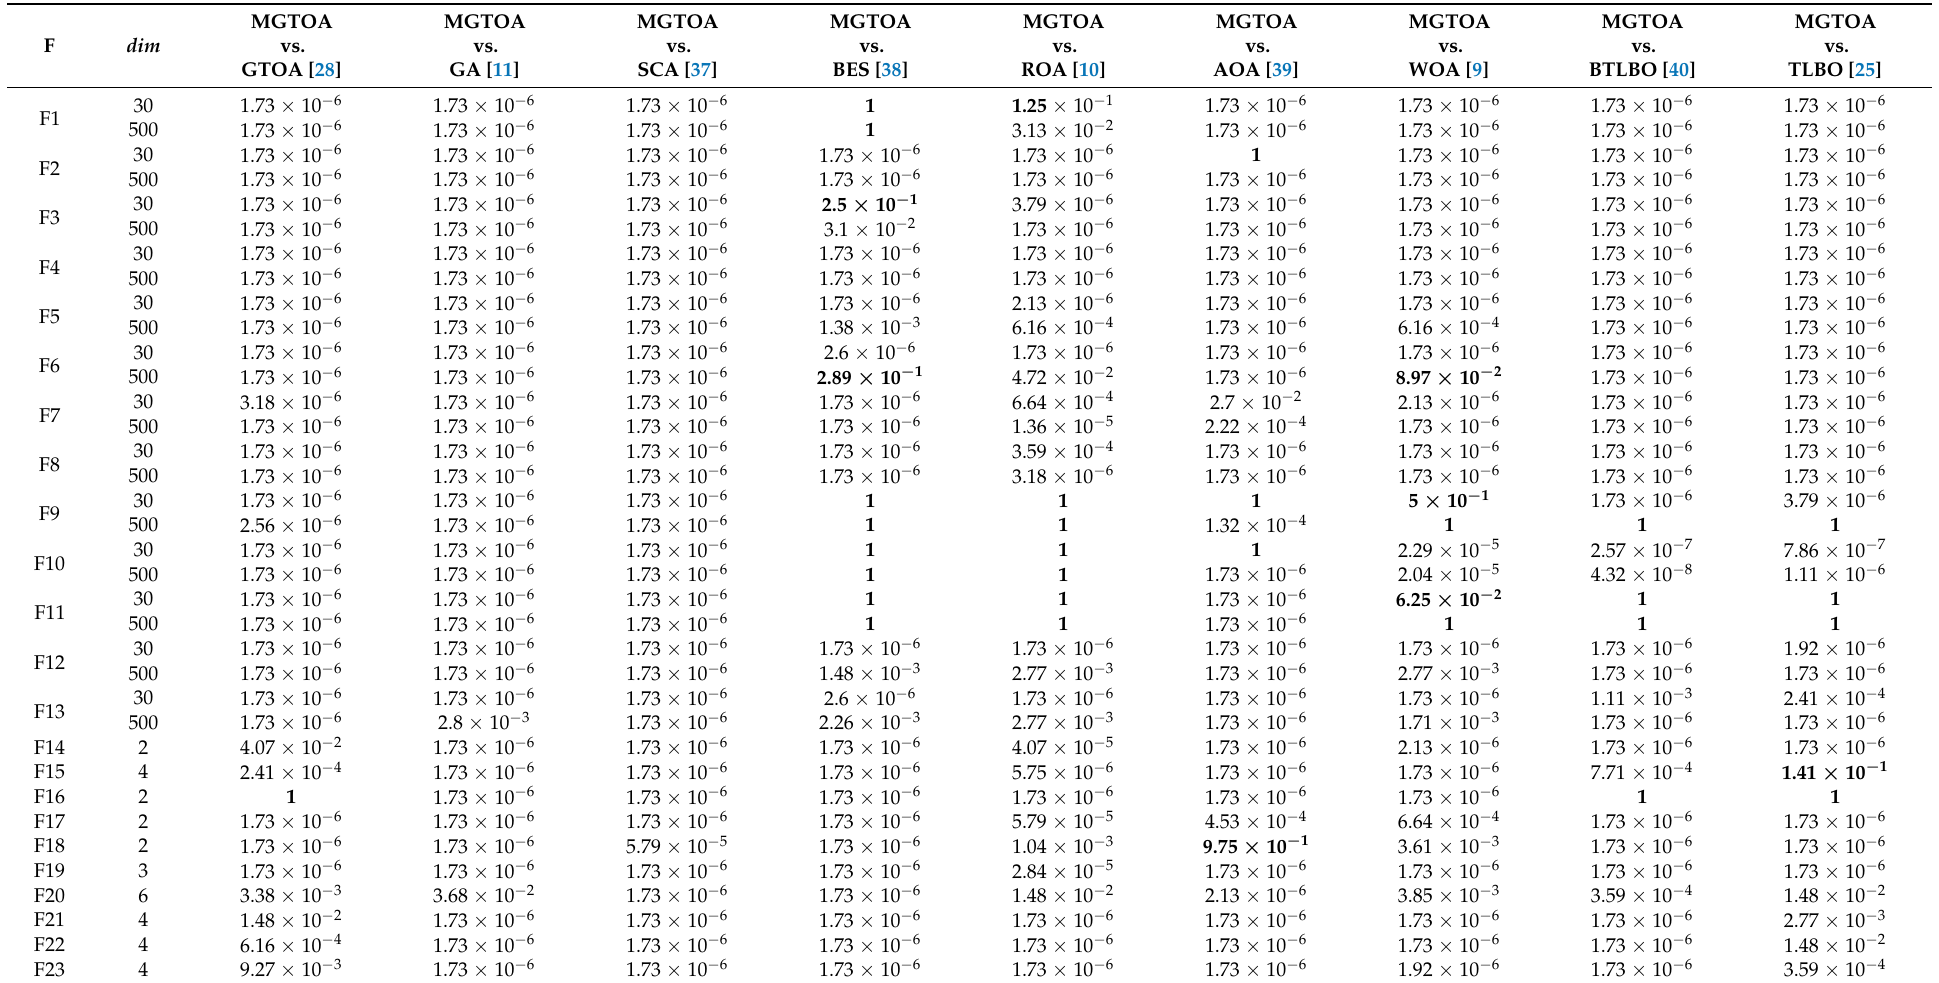
Table 6. Experimental results of Wilcoxon rank sum test on 23 standard benchmark